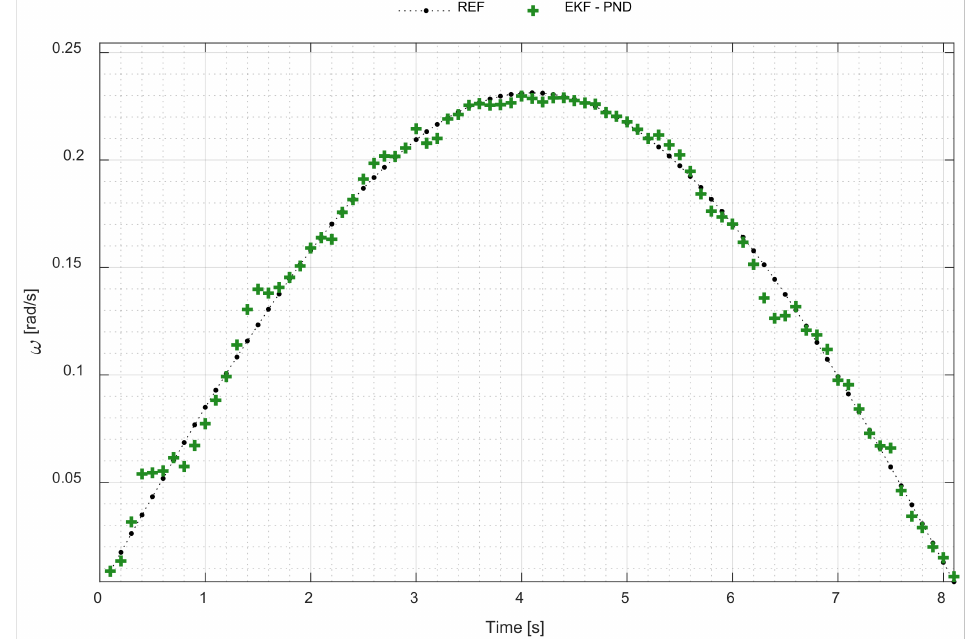
Figure 14. Angular velocity of the antenna motion estimated with